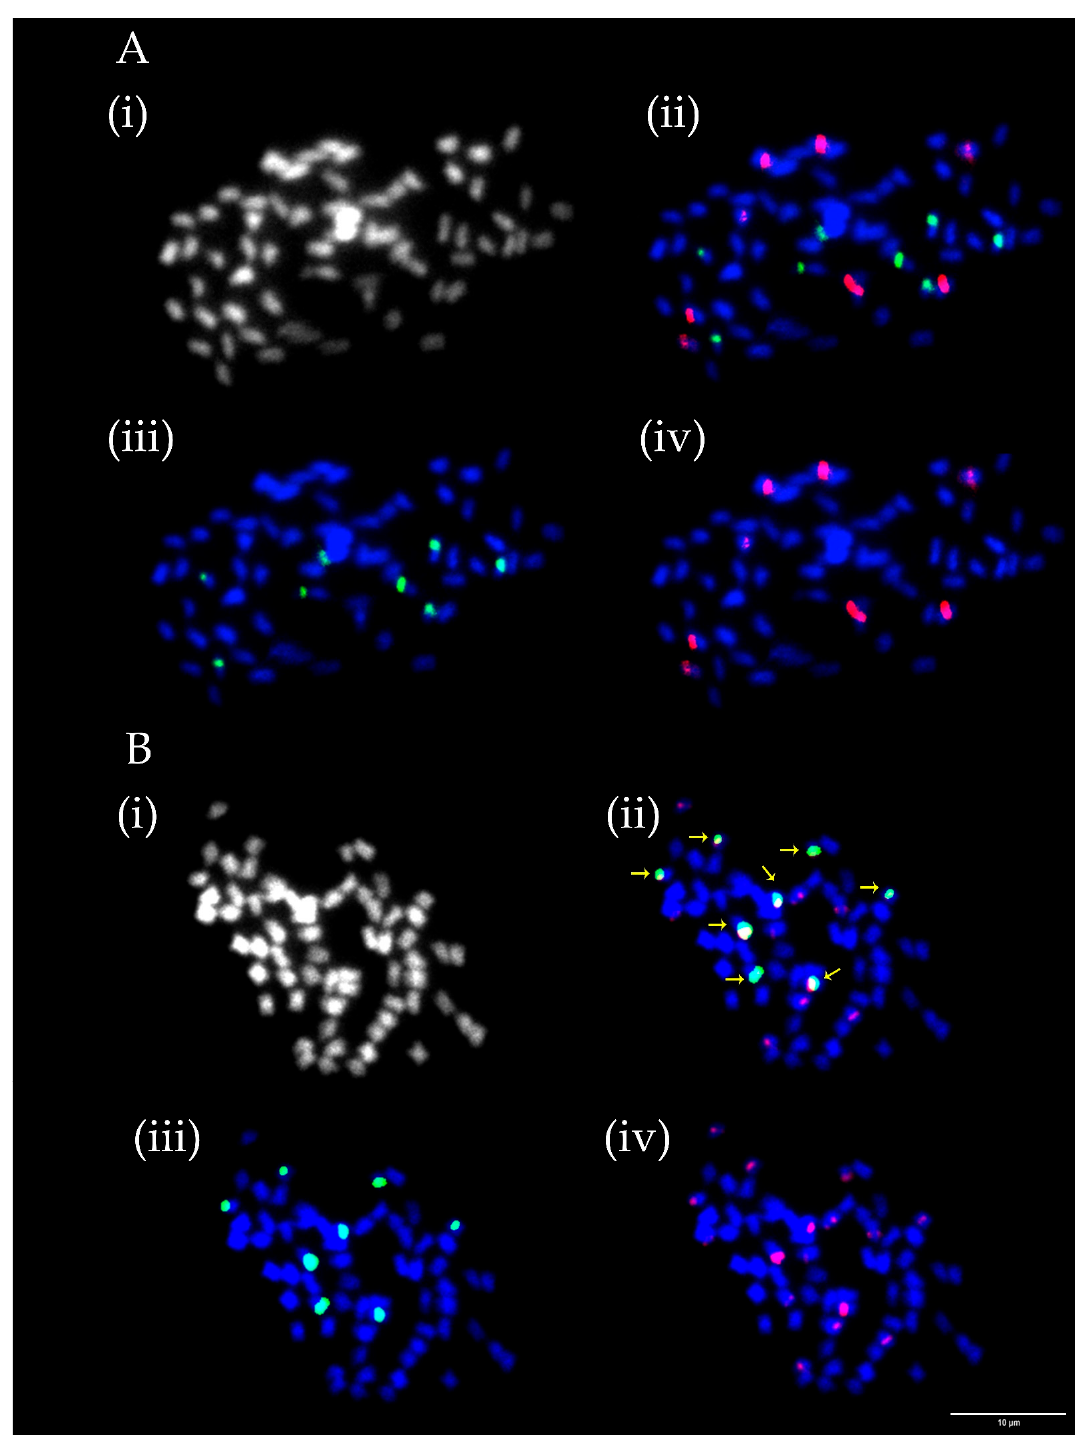
Figure 2. Numbers and localization of 5S (red) and 26S (green) loci on chromosomes of two T. medium ecotypes. ( A ) T. medium variety Ruža with eight 5S and eight 26S rDNA loci all occurring separately on different chromosomes. ( B ) T. medium ecotype 5 with 16 5S and eight 26S rDNA loci with all 26S rDNA loci co-localized with 5S rDNA loci. Four pictures are presented for each ecotype including chromosome spread (i) without fluorescent signals, (ii) with merged signals, (iii) with only 26S rDNA signals and (iv) with only 5S rDNA signals. Yellow arrows indicate T. medium ecotype 5 chromosomes with overlapping signals. Scale bar = 10 μ m.